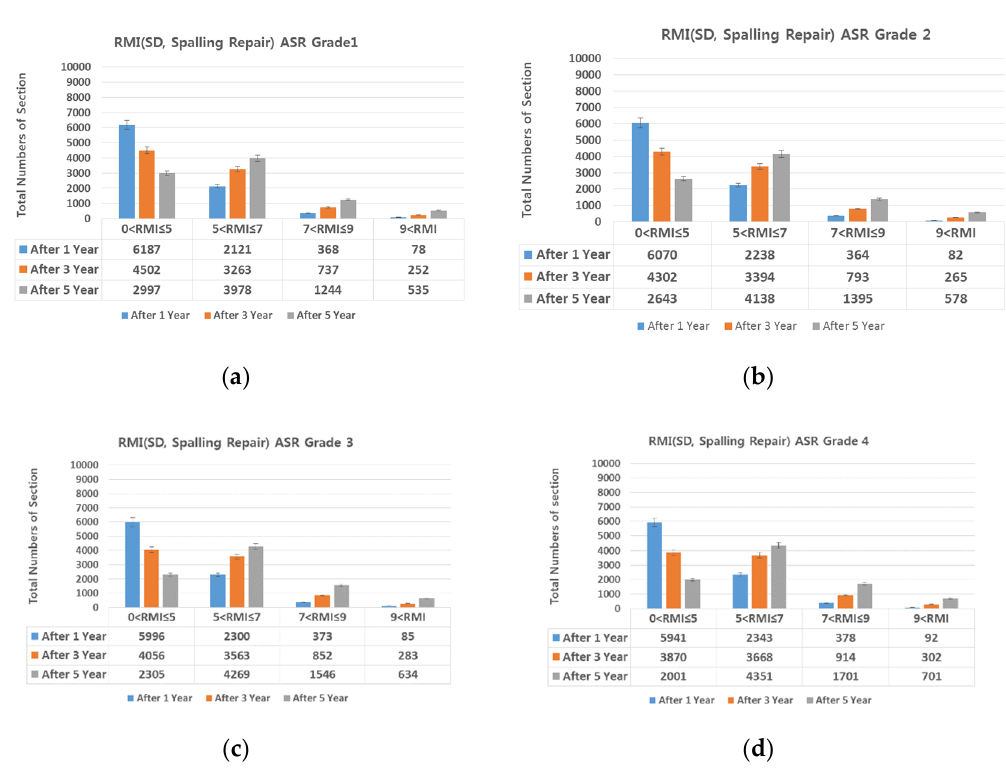
Figure 16. ( a ) spalling repair and ASR grade 1; ( b ) spalling repair and ASR grade 2; ( c ) spalling repair and ASR grade 3; and ( d ) spalling repair and ASR grade 4.